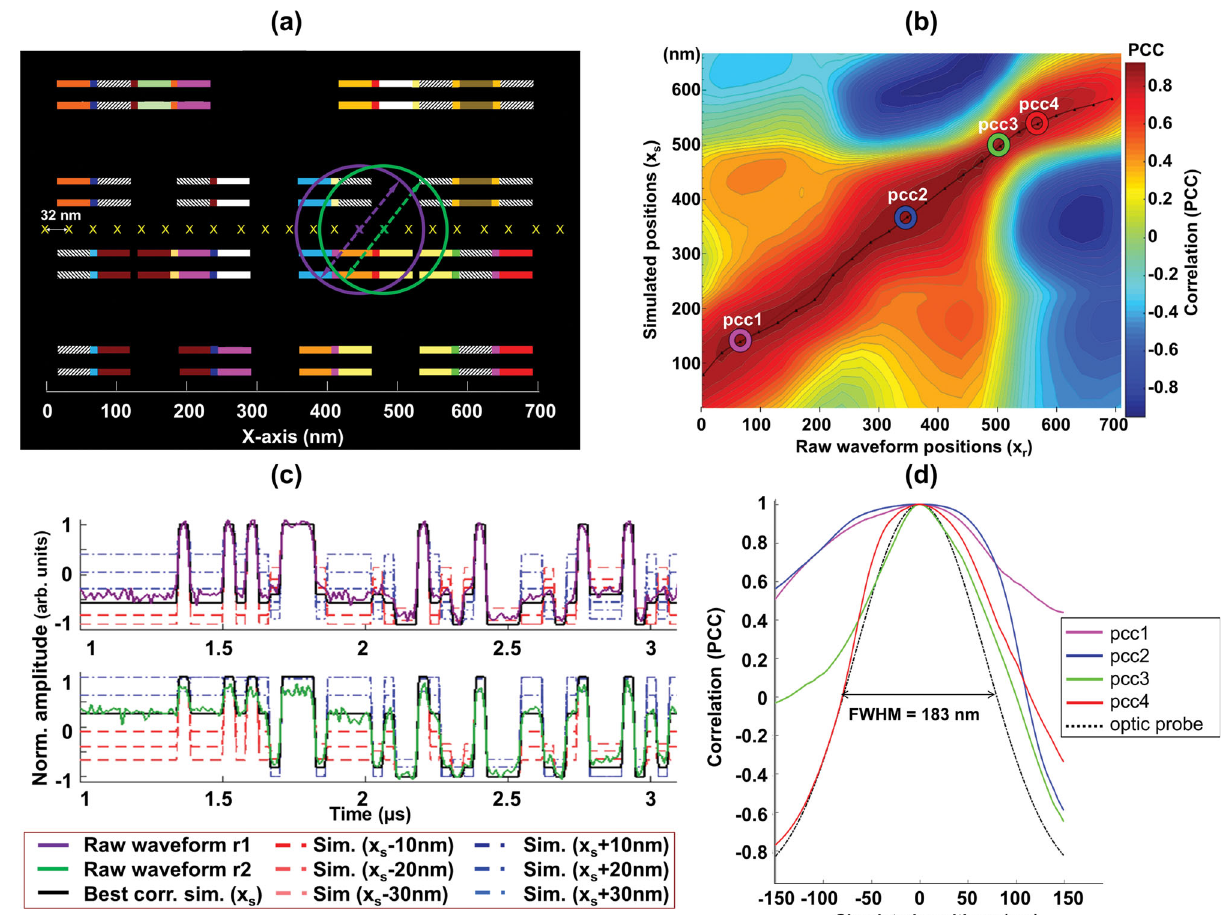
Fig. 2 | Accurate probe positioning at the target transistor. a Physical layout of cell (670nm wide) under observation. The tiny squares represent the gate- fi n overlap and the longer horizontal bars represent the source or drain segments of the fi n. Thepolygons with the same color fl uctuate with the same electrical signal while polygons with diagonal textures are power supplies and do not toggle. The yellow ‘ X ’ s represent the raw waveform positions ( x r ) from which each of 23 optically probed (raw) waveforms are collected within the cell. Raw waveforms r1 and r2 are collected from positions indicated by the violet and green circles with diameters equal to the FWHM of the probe. b LP waveforms traces comparing r1 and r2 with CLA simulations. The best correlated simulations positions ( x s ) for r1 ( x s =471nm) and r2 ( x s =497nm) are colored in black. Overlaid are also simula- tions at positions x s − 10nm, − 20nm, and − 30nm in red and x s +10nm, +20nm,